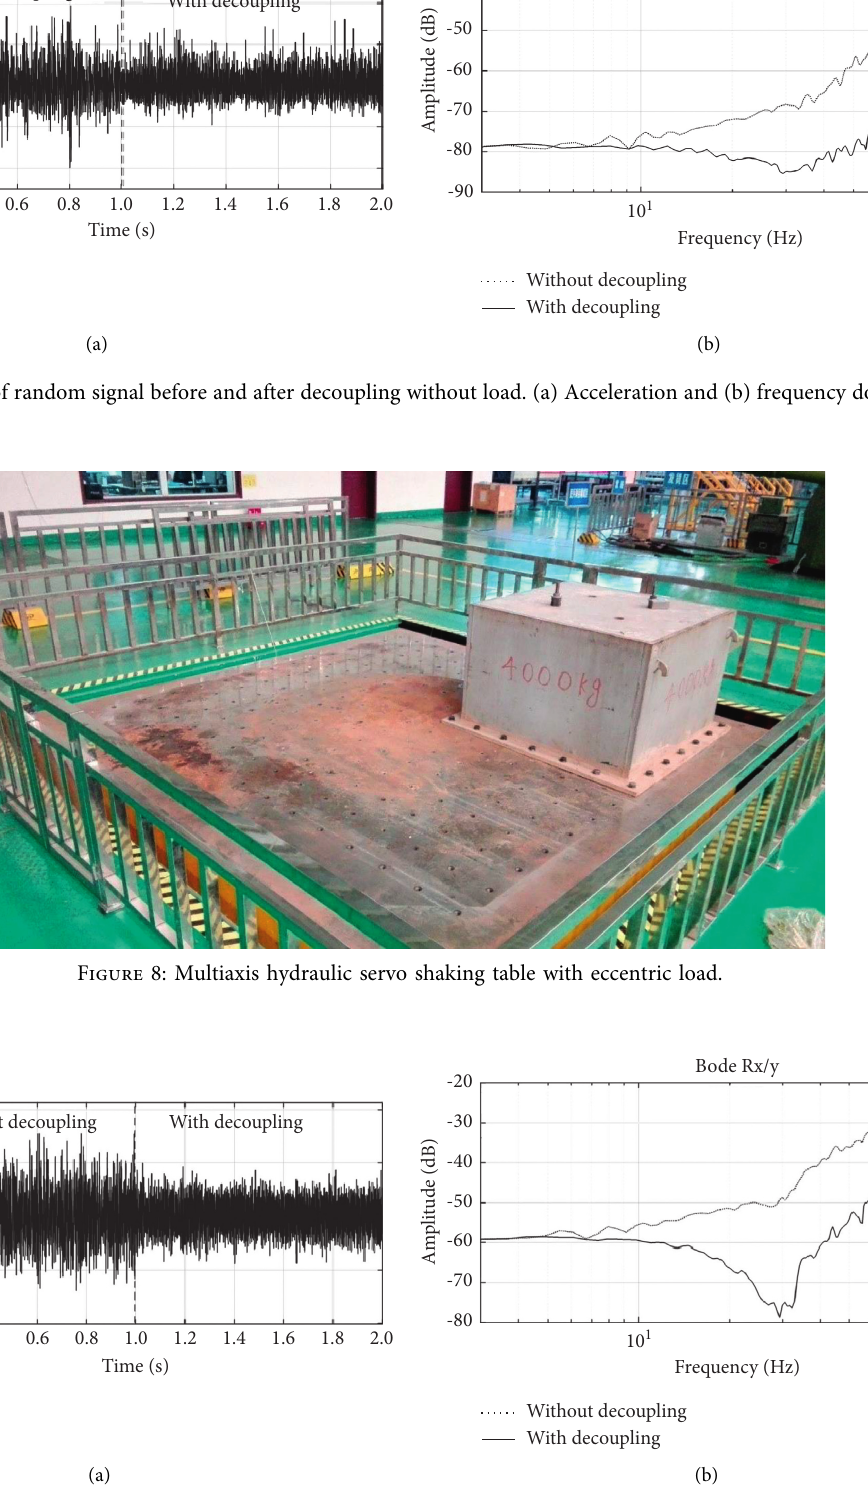
Figure 9: Comparison of random signal before and after decoupling with eccentric load. (a) Acceleration and (b) frequency domain